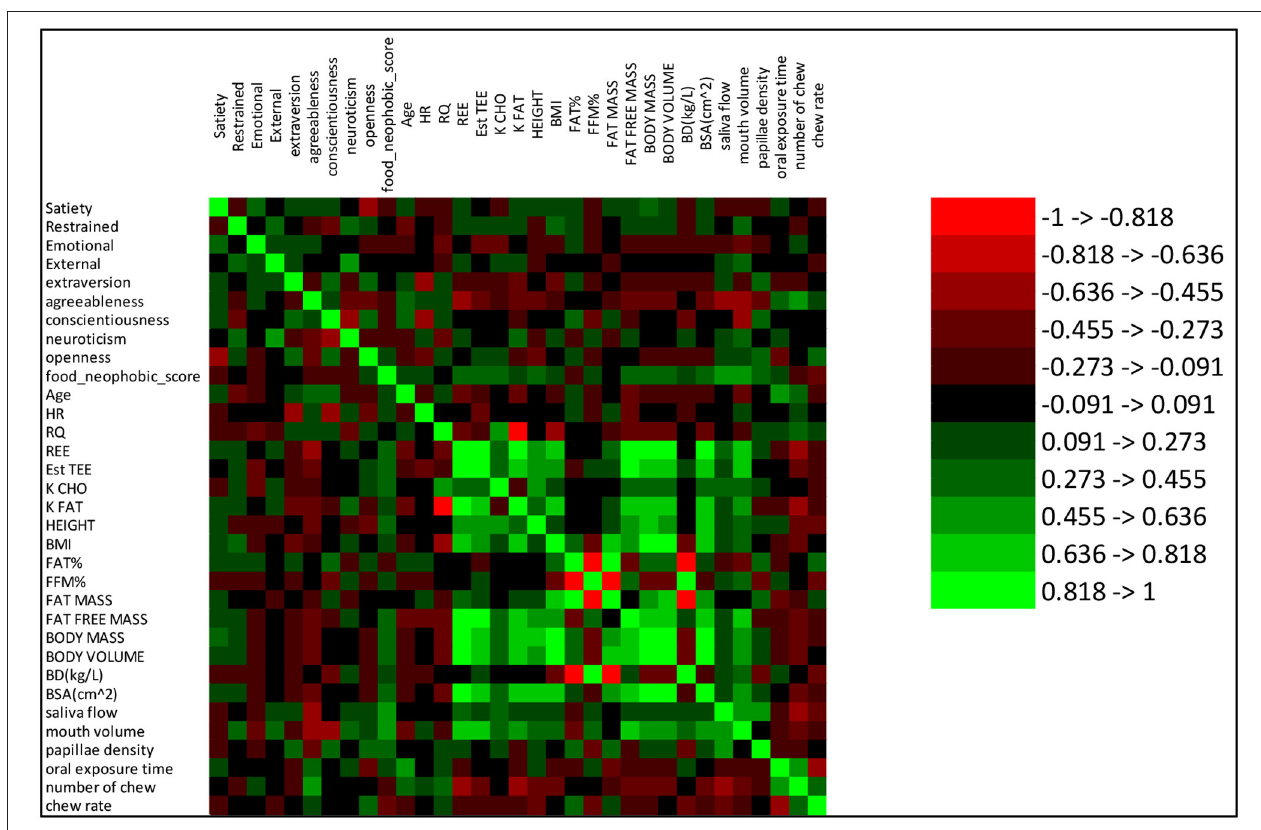
FIGURE 4 | Correlations between measured variables. The color scheme number reference is on the right side of the figure. Red and green indicate negative and positive correlations,